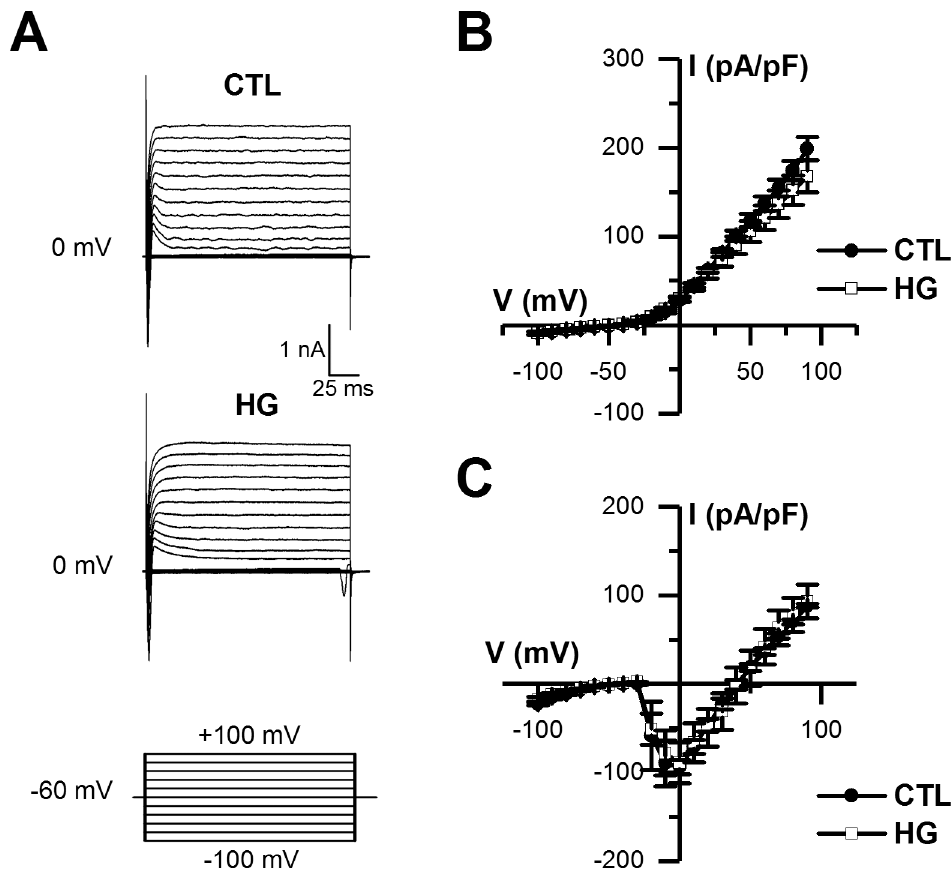
Fig 3. Voltage-gated currents were unaffected by high glucose conditions. A, show representative traces of macroscopic voltage-gated outward and inward currents recorded in voltage-clamp mode (holding potential set at -60 mV) by the application of a voltage step protocol (inset), in cultured DRG neurons maintained in either control (CTL, top traces) or high glucose (HG, bottom traces). B-C, the I-V plot summarize the mean outward current density (B) and mean inward peak current density (C) obtained at different step voltages, in both experimental conditions. All data are represented as mean ± SEM, n = 5 for each condition.